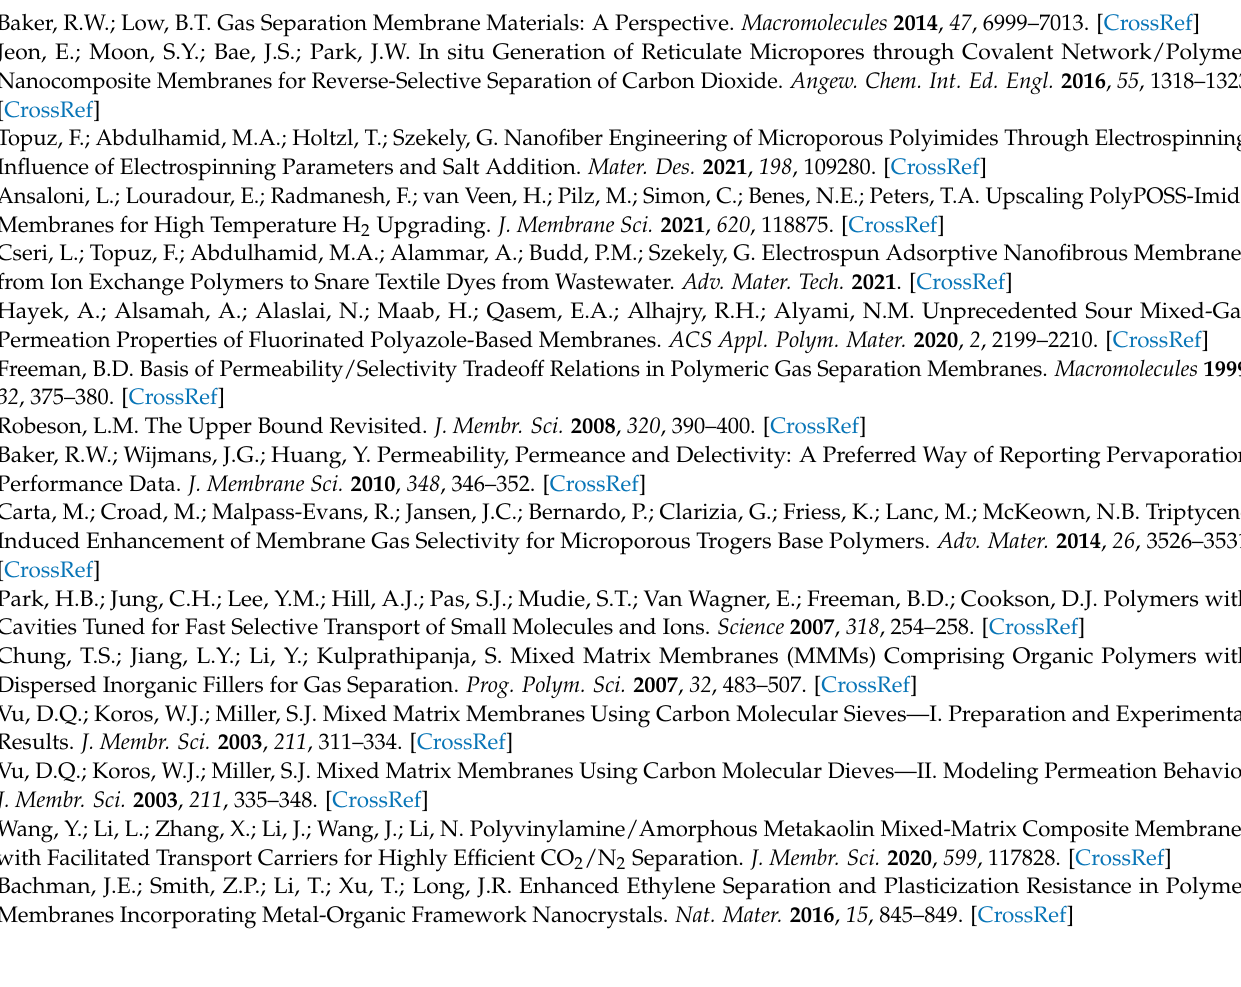
PIs; Table S4: 5AP/6FDA-Durene activation energy (E p ) of permeation for CO 2 , N 2 and CH 4